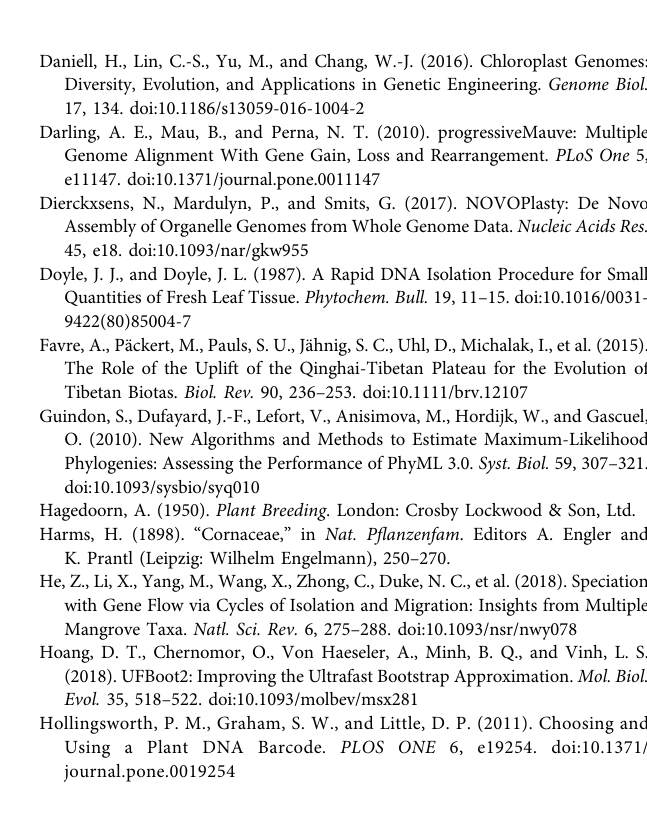
Supplementary Figure S1 | Map of three Aucuba plastomes newly generated in this study. Supplementary Figure S2 | Alignment of Aucuba plastomes using mVISTA, showing the percentages of sequence identity